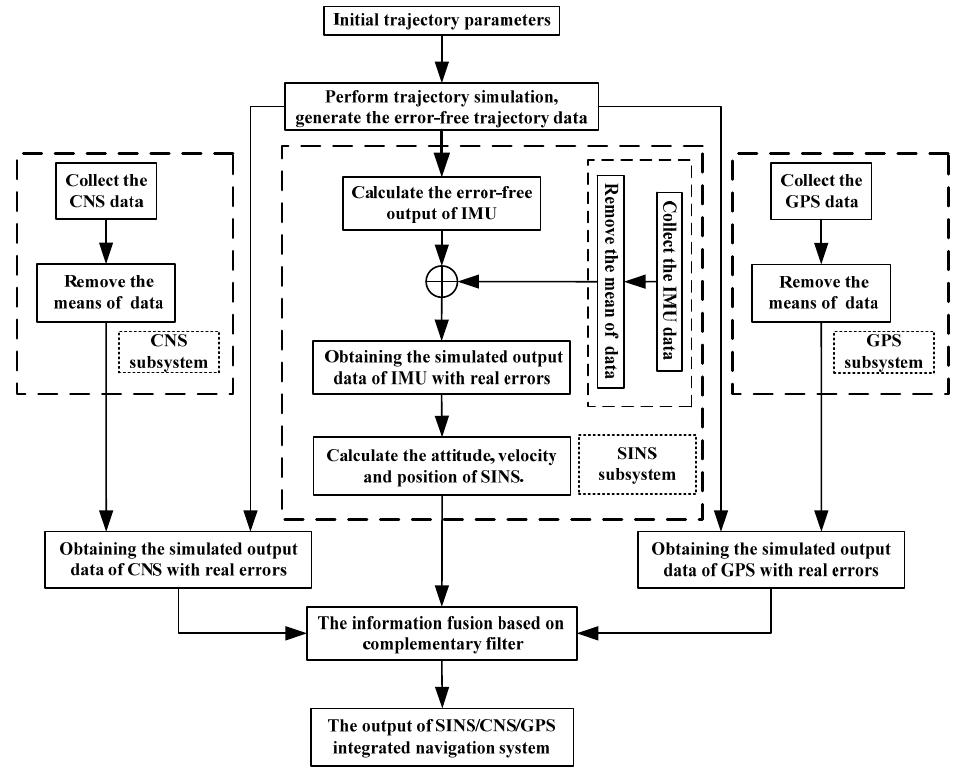
Figure 12. Flow chart of semi-physical simulation for SINS/CNS/GPS integrated navigation.